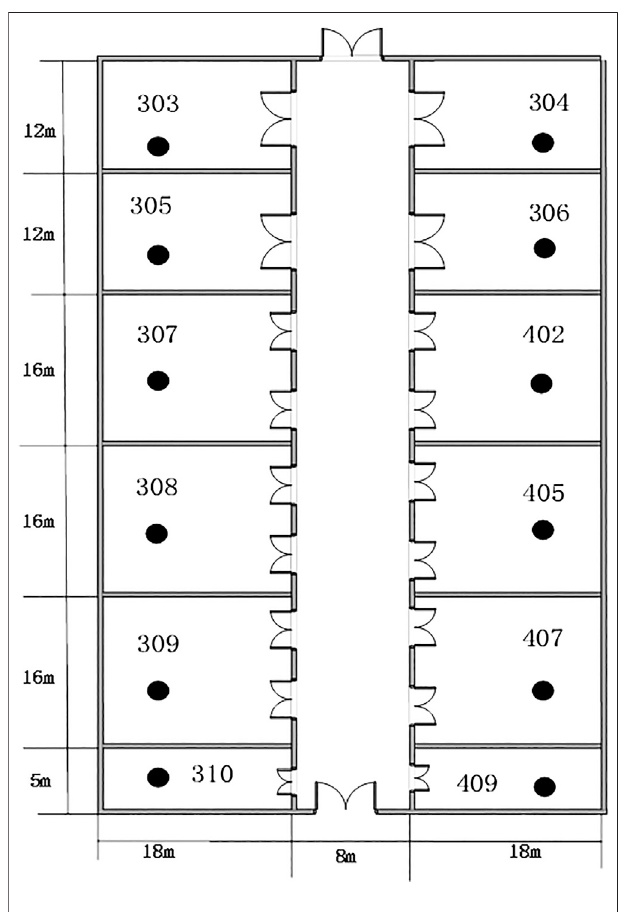
FIGURE 1 | The experimental environment was located on a fourth fl oor inabuilding.Thebird ’ s-eyeviewofthefourth fl oorisshowninthe fi gure.Black dots represent the layout of wireless FM signal